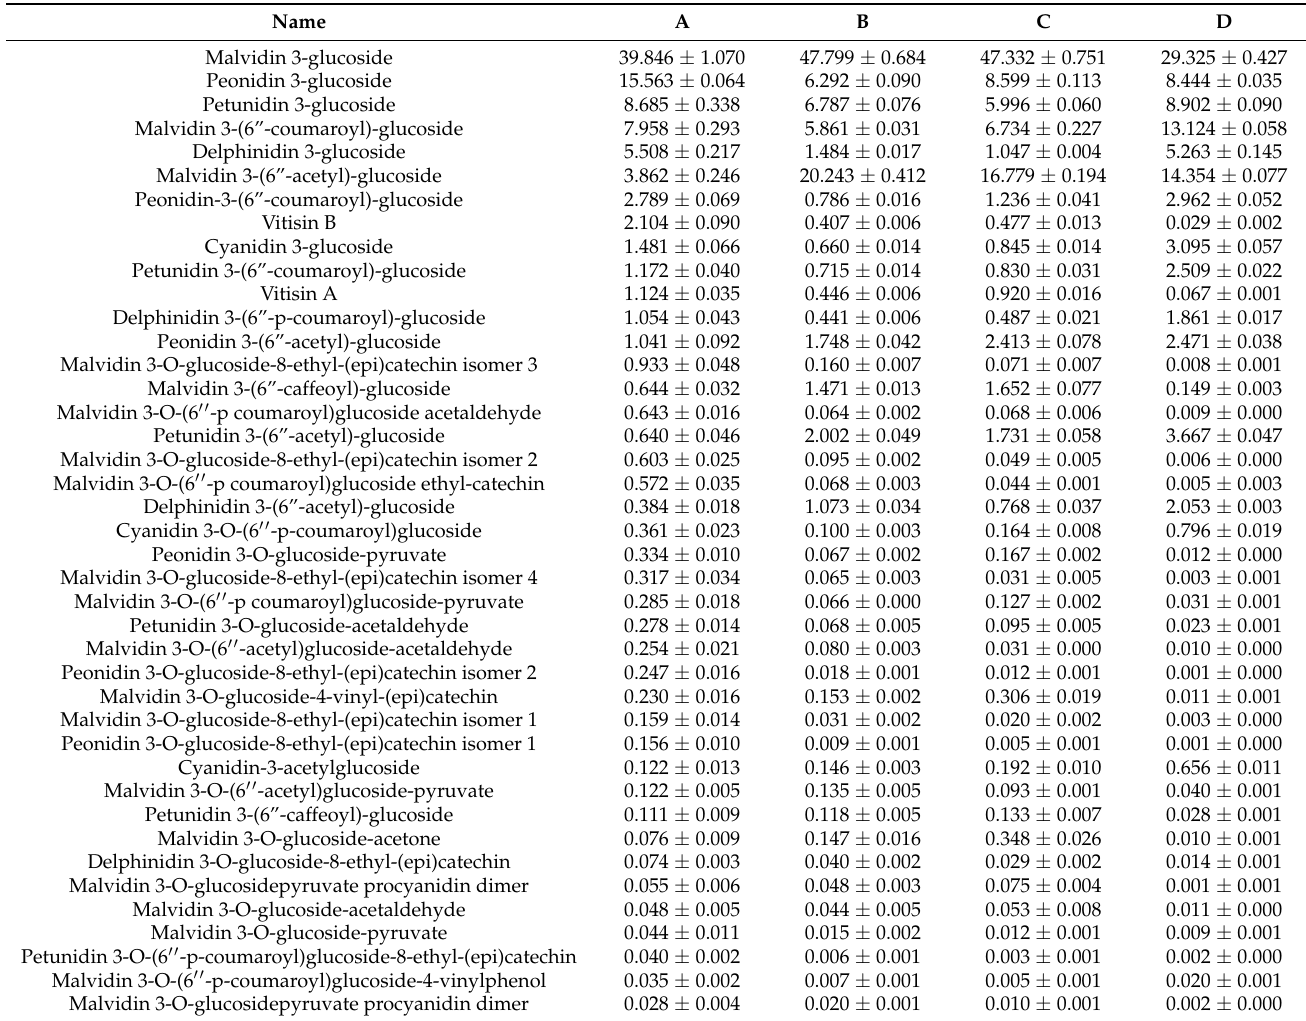
Table 3. Relative percentages (mean ± SD) of the 41 anthocyanins